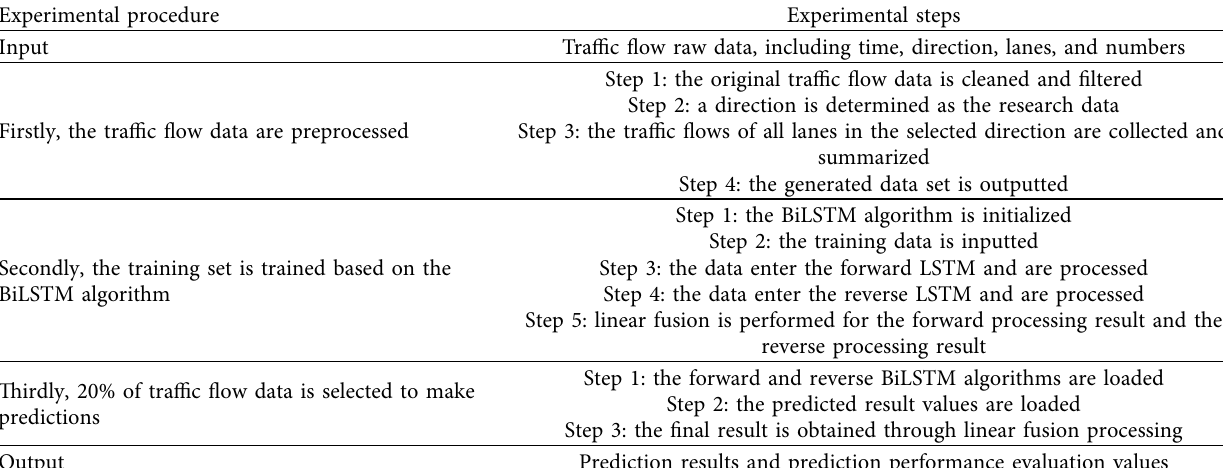
Table 1: Experimental procedure and experimental steps. Experimental procedure Experimental